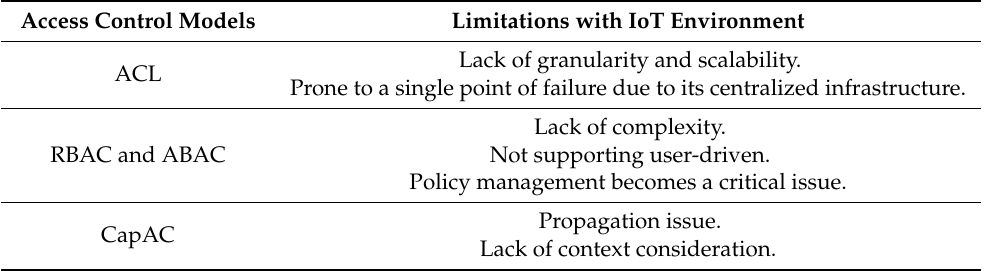
Table 1. Access control drawbacks with Internet of Things (IoT)